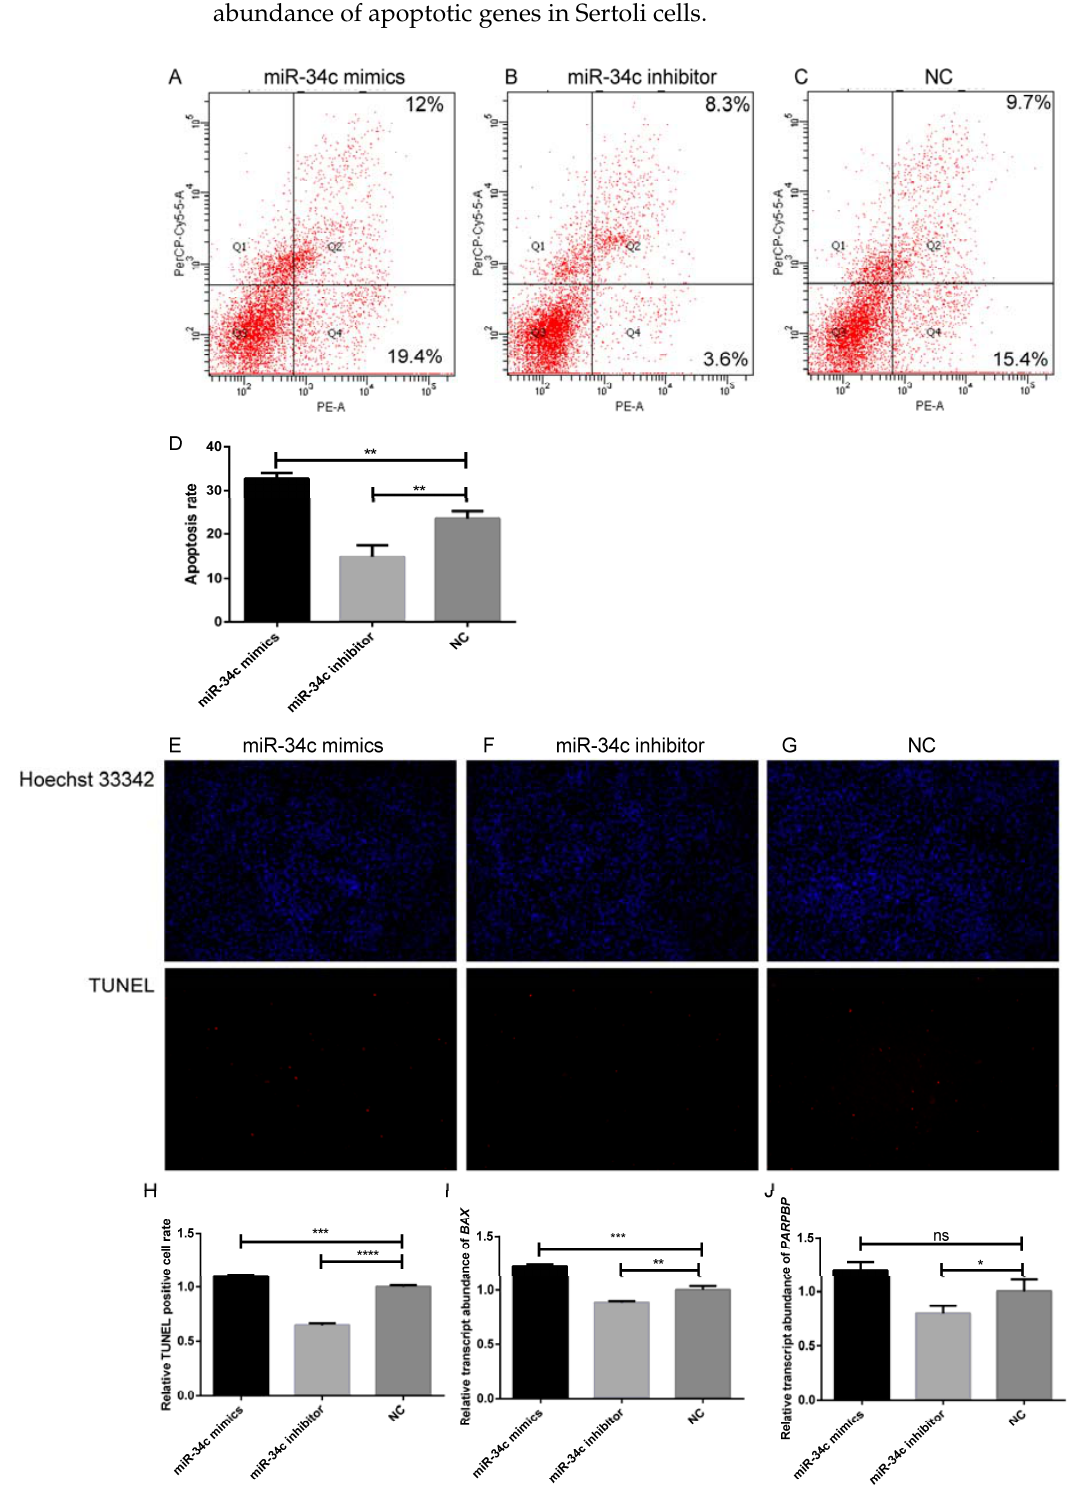
Figure 3. MiR-34c promotes the apoptosis of bovine Sertoli cells. ( A – D ) The rate of apoptosis in Sertoli cells was detected by flow cytometry, and apoptosis in Sertoli cells was analyzed by flow cytometry. ( E – H ) The TUNEL assay showed apoptotic cells among bovine Sertoli cells after transfection, and cell nuclei were counterstained with Hoechst 33342 (100 × ), Scale bar = 200 µ m. ( I , J ) Data were presented as means ± SEM. Standard Error of Mean (SEM) was indicated by error bars. p < 0.05 was considered to be statistically significant. * p < 0.05; ** p < 0.01; *** p < 0.001; **** p <